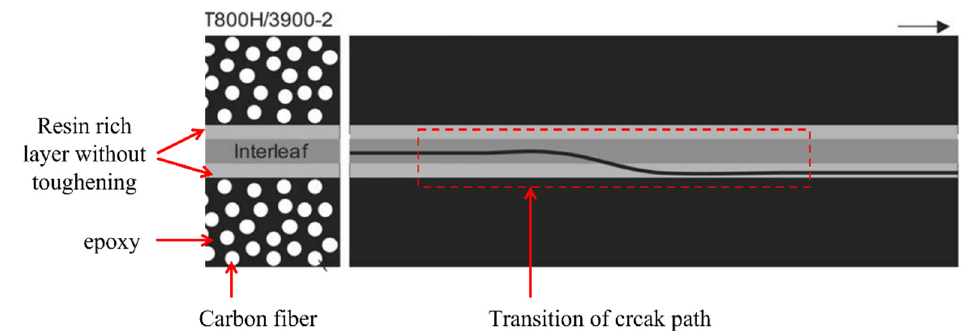
Figure 21. Schematic presentation of crack path under mode I cyclic loading.